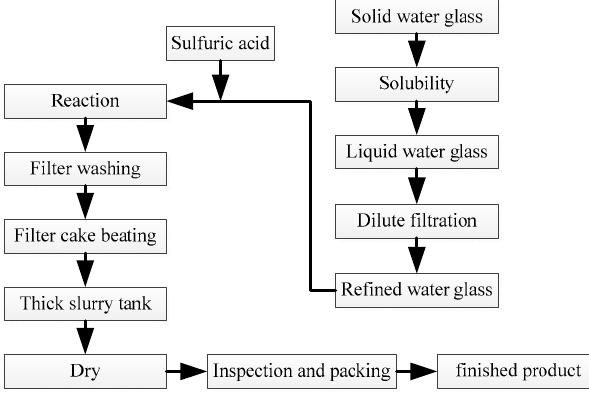
Figure 11. Process flow chart.